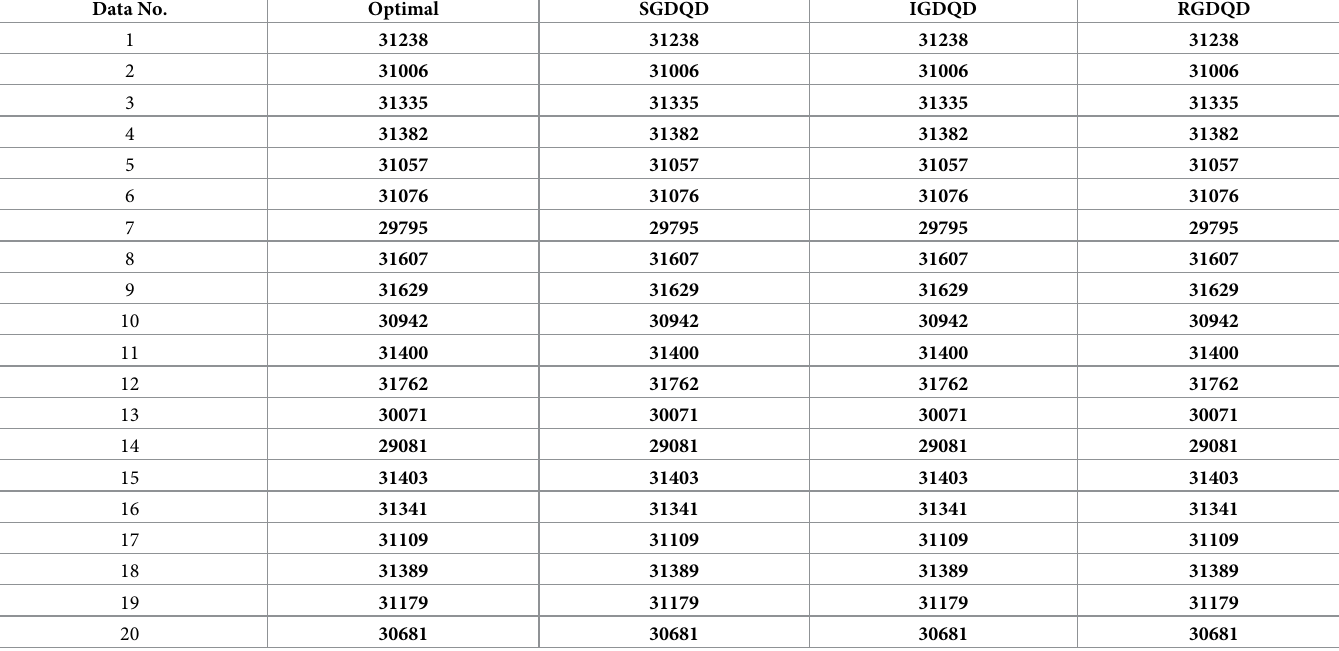
Table 7. Solutions for Q =